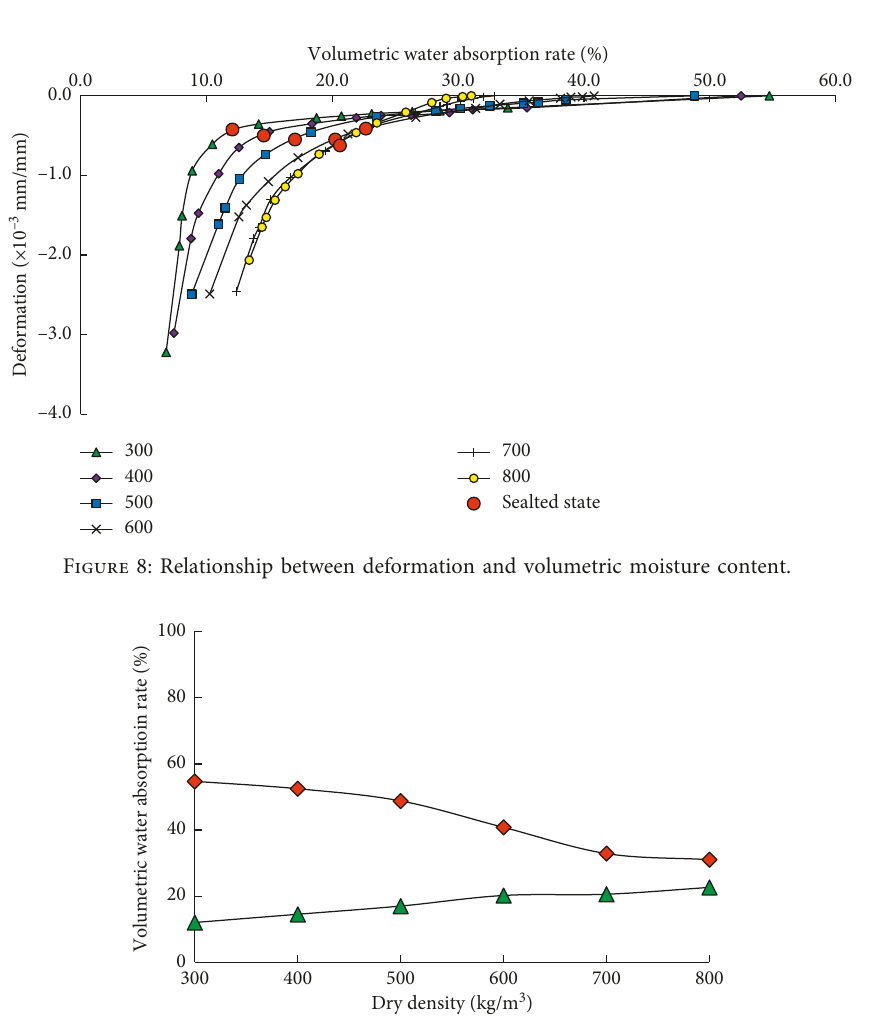
Figure 7: Relationship between shrinkage deformation and curing time (the improved drying shrinkage test).